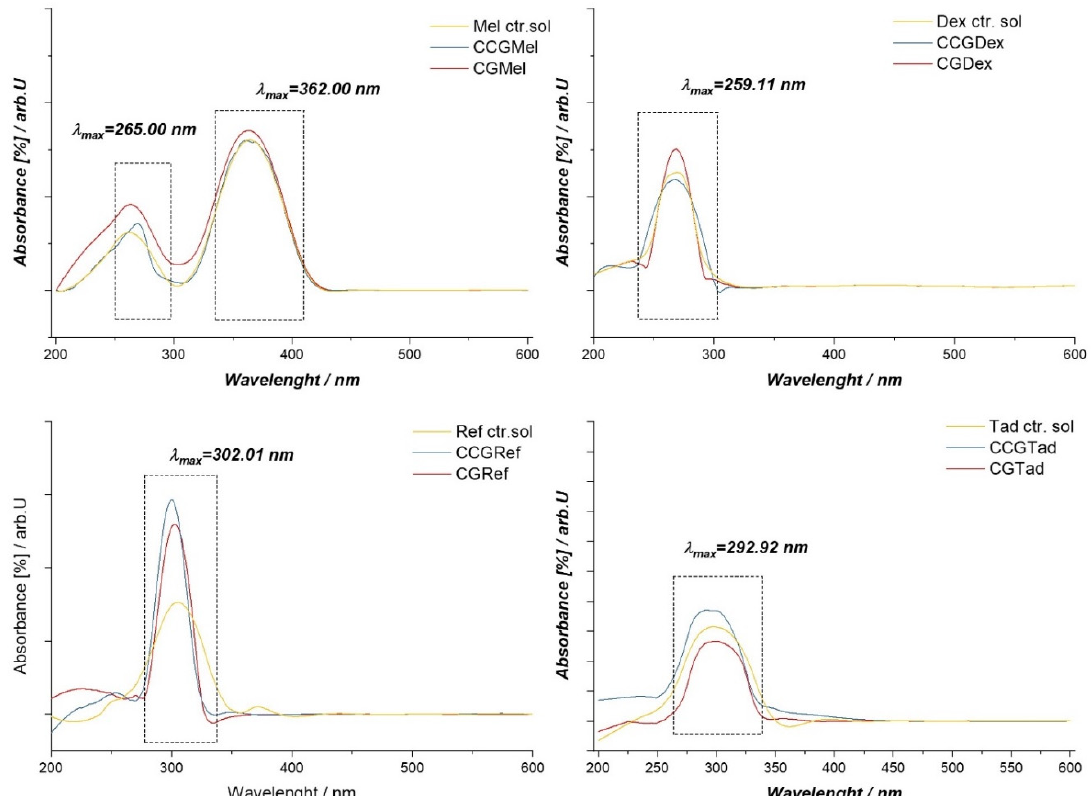
Figure 9. UV-VIS spectrum for control solutions of anti-inflammatory drugs and membranes in which these drugs were entrapped, both in type A and type B membranes.